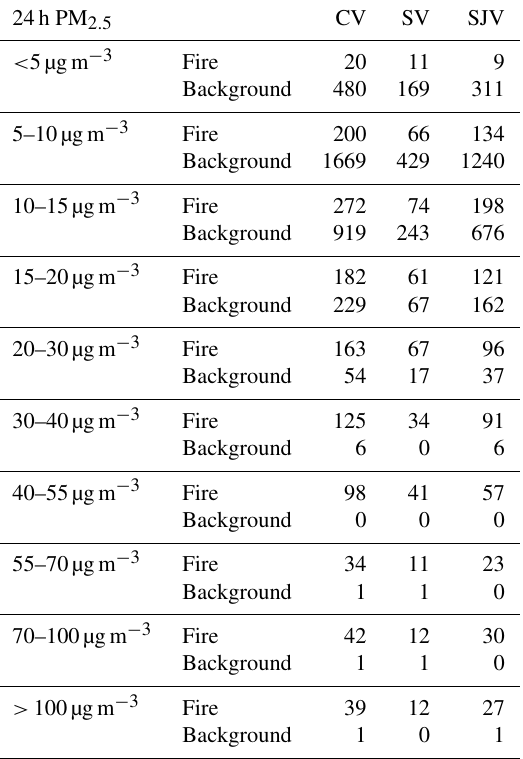
Table C3. Number of data points in each bin in Fig. 4.